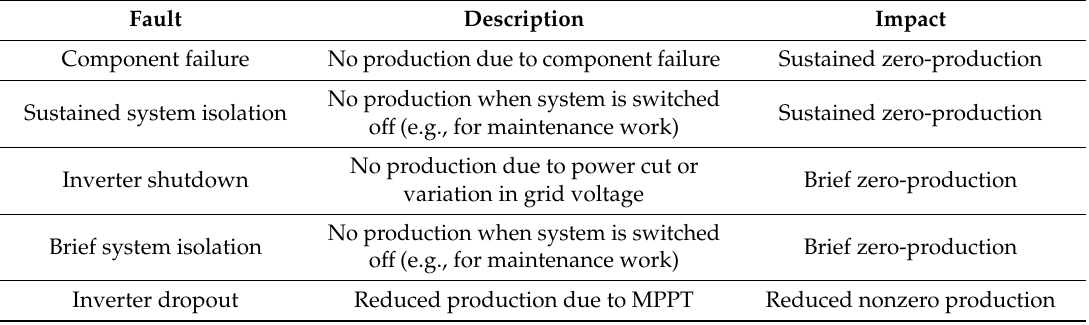
Table 1. Description of photovoltaic (PV) system faults and their impacts (Adapted from [11], Elsevier: 2010).